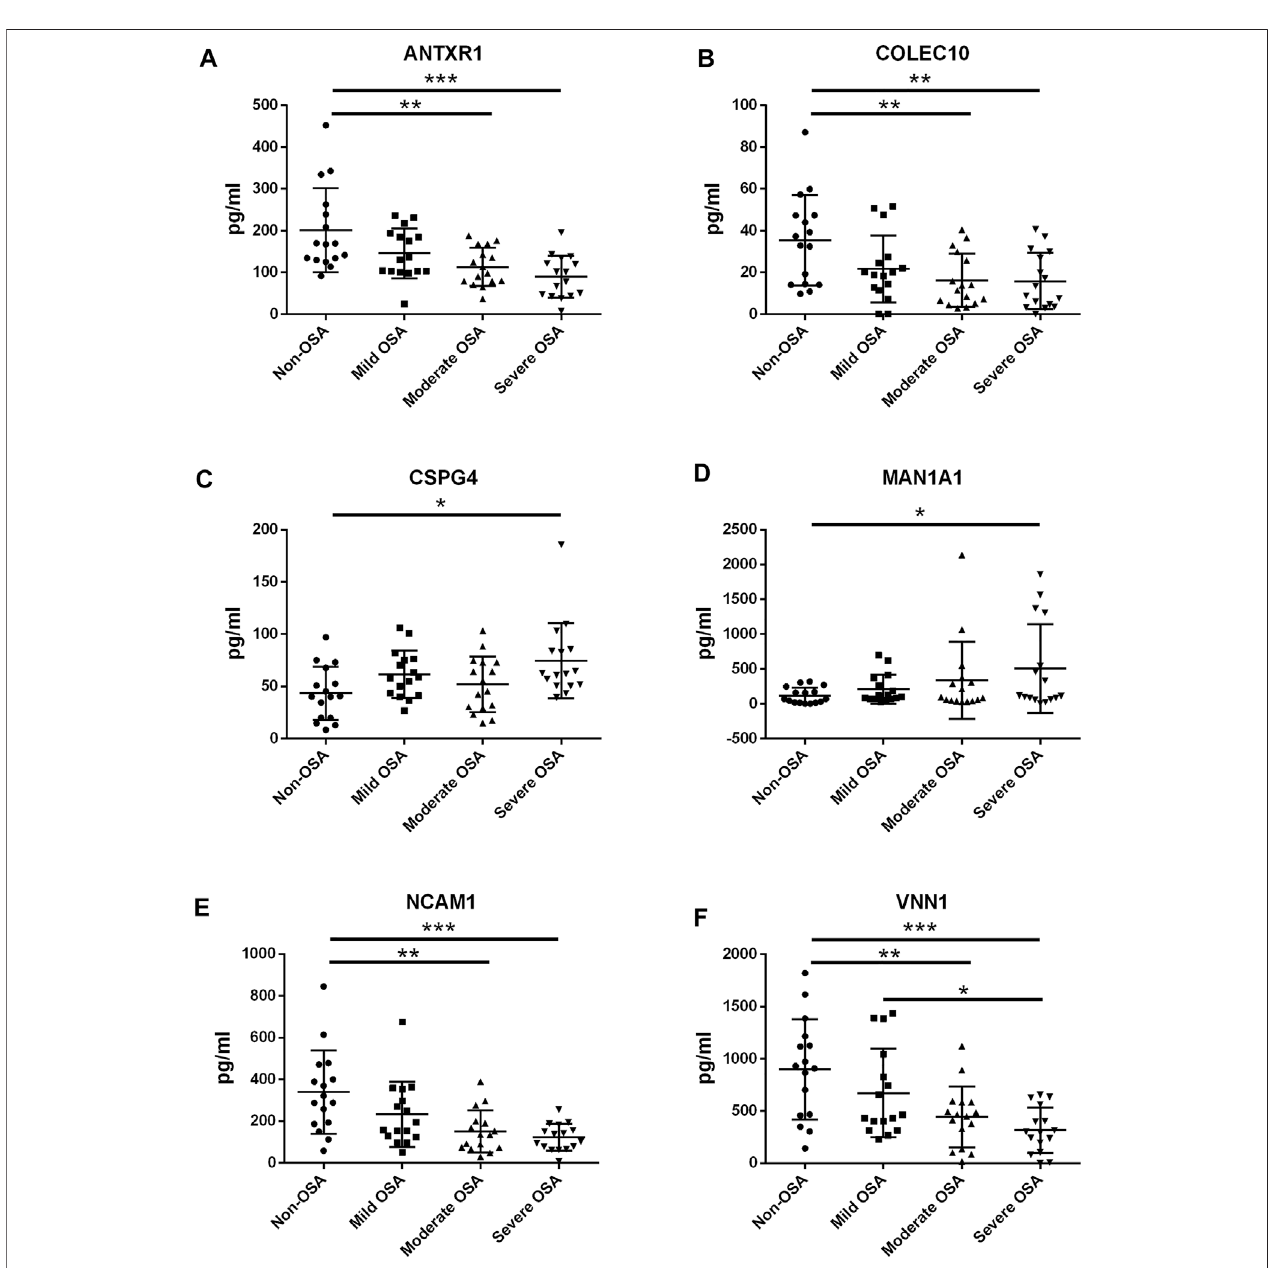
FIGURE 9 | ELISA analysis of serum protein levels of ANTXR1 (A) , COLEC10 (B) , CSPG4 (C) , MAN1A1 (D) , NCAM1 (E) , and VNN1 (F) in the pediatric OSA. Signi fi cant differences between the treatment groups are indicated as * p < 0.05, ** p < 0.01, and *** p < 0.001.